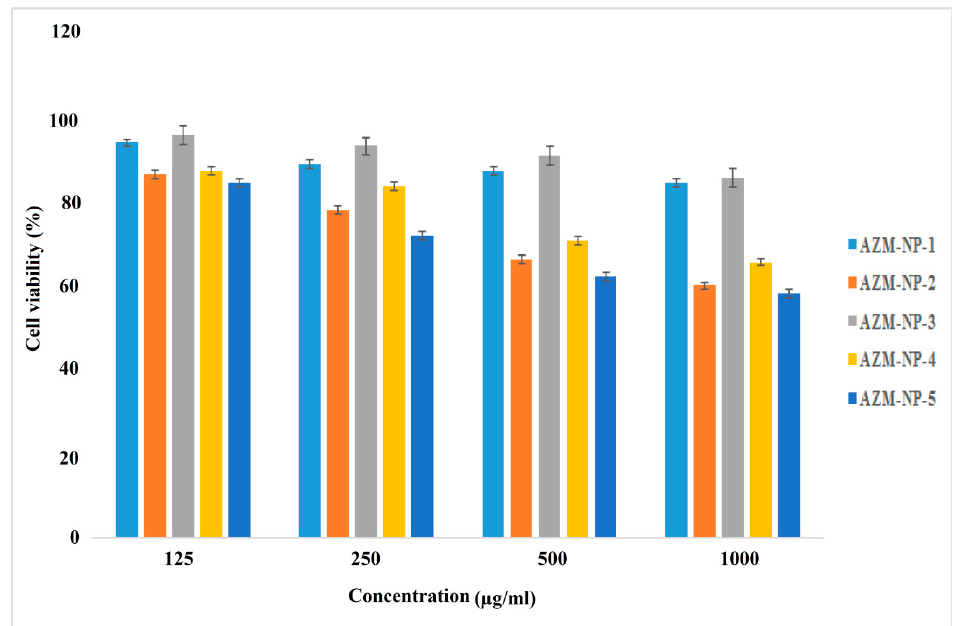
Figure 4. Cell viability of L929 (mouse fibroblast) cells (ATCC) after treatment with Eudragit ® L100 nanoparticles for different concentrations of nanoparticles: 125, 250, 500, and 1000 µL/mL. Cell viability measured by (3-(4,5-dimethylthiazol-2-yl)-2,5 diphenyl tetrazolium bromide) (MTT) assay. Data are expressed as the mean ± SD of three separate experiments (mean ± SD, n = 6). Table 3. Physicochemical parameters of the ocular inserts of azithromycin (mean ± SD, n = 3 ) . Formulation